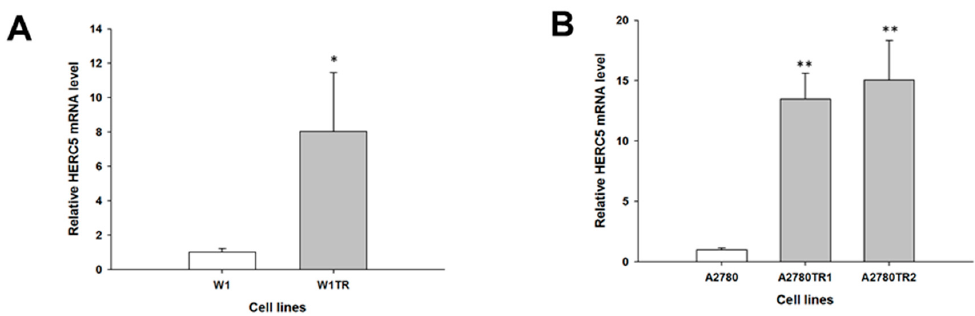
Figure 4. Expression analysis (Q-PCR) of the HERC5 gene in: W1 ( A ); and A2780 TOP-resistant cell lines ( B ). The figure presents relative the gene expression in resistant cell lines (grey bars) with respect to the sensitive cell line (white bars), assigned as 1. The values were considered significant at * p < 0.05 and ** p < 0.01.